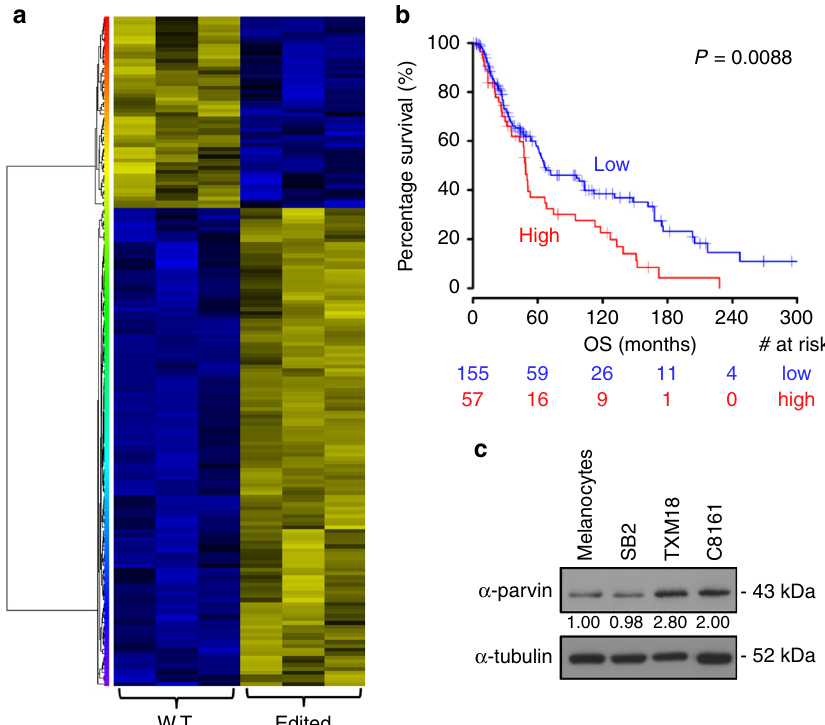
Fig. 1 Role of PARVA in melanoma patients overall survival. a Microarray analysis of SB2 KD- ADAR1 cells transfected with wild type or edited miR-378a-3p. Heat map of the genes with statistically signi fi cant change expression ( P < 0.01; log ratio 0.5). b Comparison of overall survival of skin metastatic melanoma cancer patients with high or low PARVA expression. The number of patients at risk in low/high PARVA groups at different time points are presented at the bottom of the graph. c Western blot analysis of melanoma cell lines shows decreased α -parvin expression in the normal melanocytes and low metastatic cells and high expression in the highly metastatic melanoma cells (TXM-18 and C8161). Representative of three independent biological